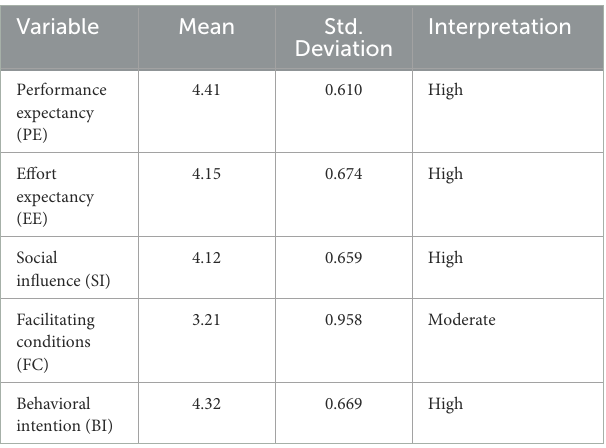
TABLE 1 Malaysian ESL teachers’ technology acceptance levels in the post-COVID-19